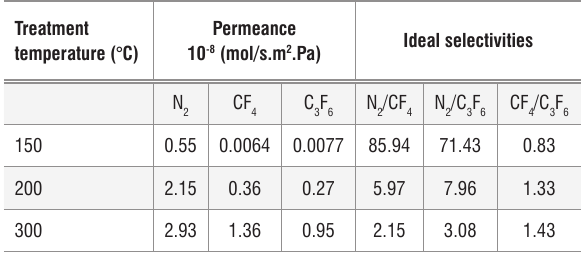
Single gas permeation Before comparing the gas permeabilities of the various membrane types, the effect of the heat treatment used to attach the Teflon layer onto the MFI zeolite in the composite membrane was evaluated in terms of gas permeance values. The results are shown in Table 2. Single gas permeance values obtained for the Teflon-coated mordenite framework inverted (MFI) membranes at various treatment temperatures Treatment Permeance temperature (°C) 10 -8 (mol/s.m 2 .Pa)